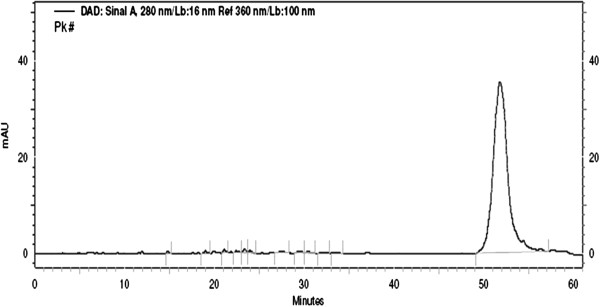
A trace of reverse phase HPLC analysis of C. nucifera lyophilized crude aqueous extract. The asterisk (*) in the figure indicates polymeric procyanidins.